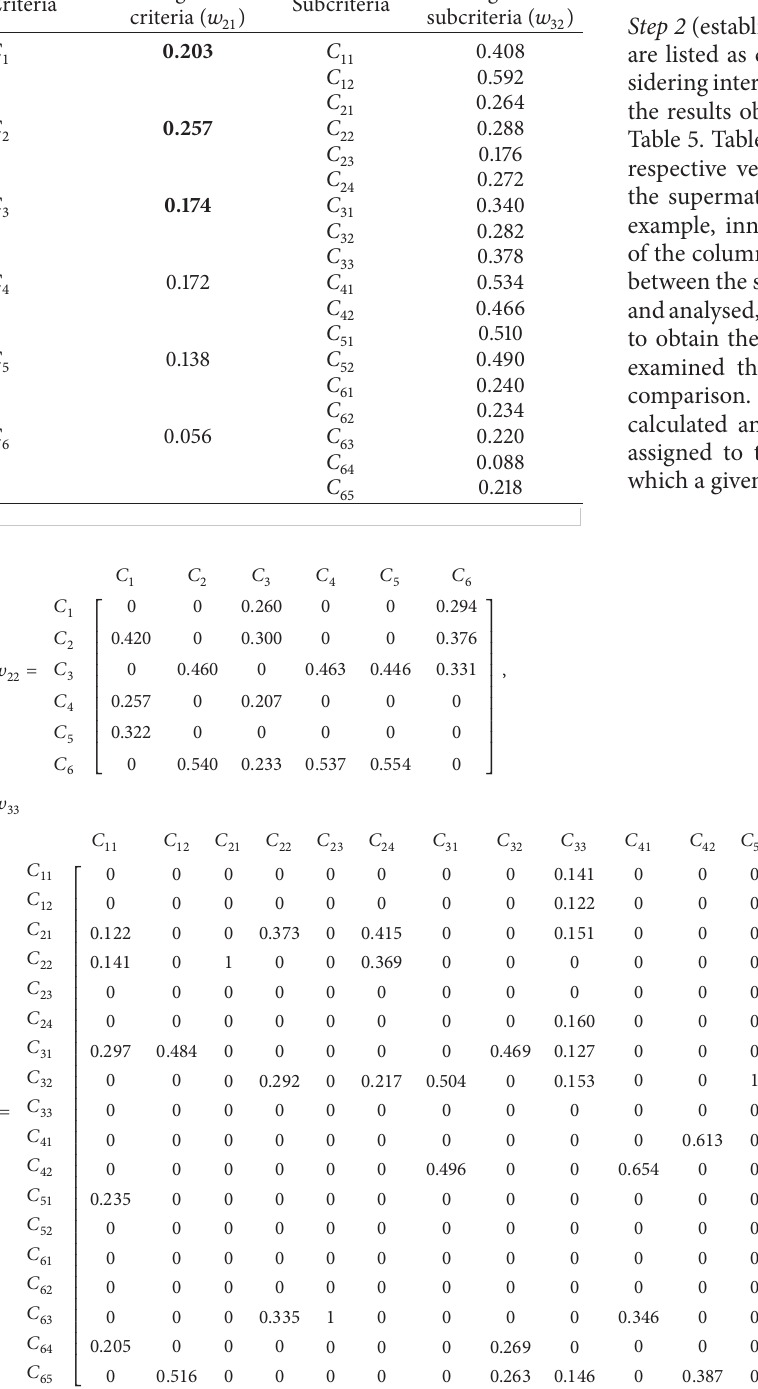
Table 4: Weights for level 2 and level